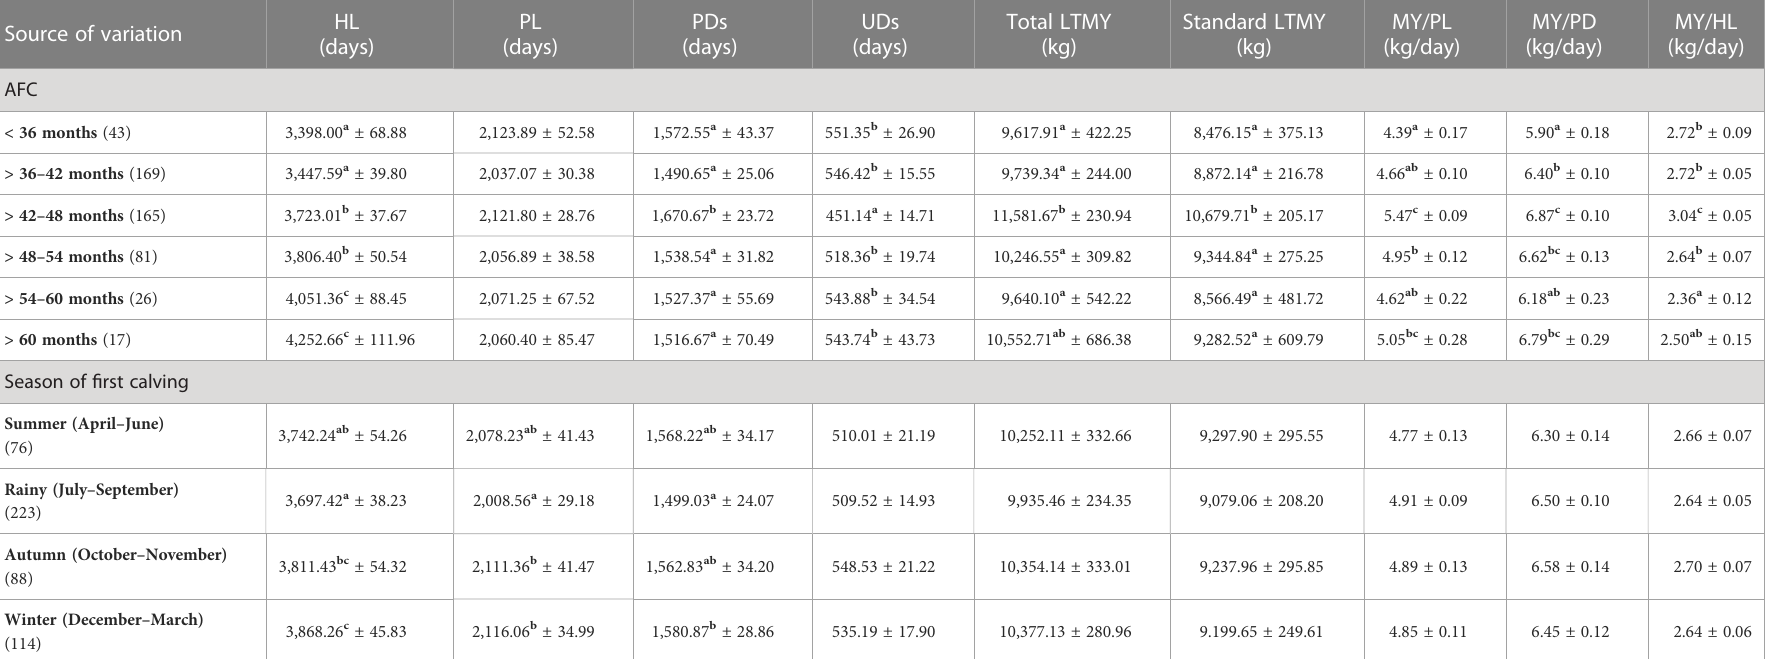
TABLE 2A A Least-squares means (LSDs) with standard errors (SEs) for lifetime performance traits in Nili-Ravi buffaloes.